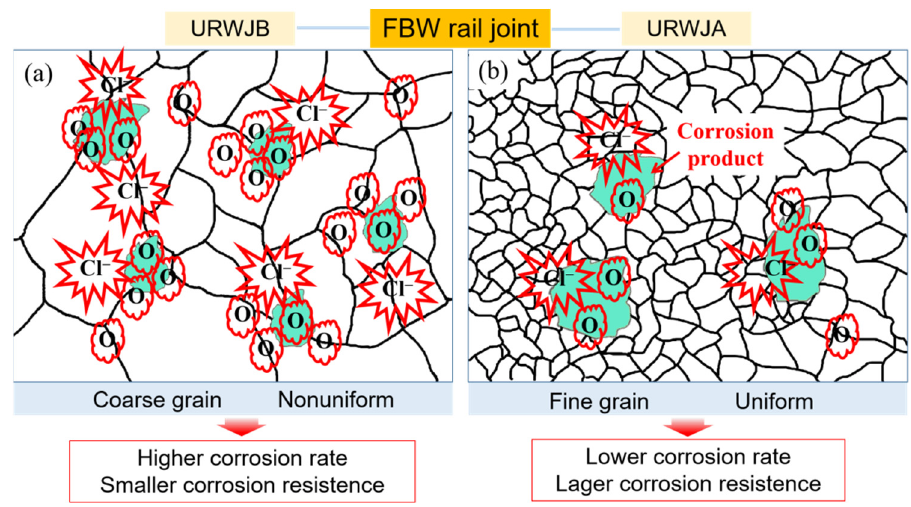
Figure 11. Schematic diagram showing the galvanic corrosion of URWJs: ( a ) URWJB, ( b )